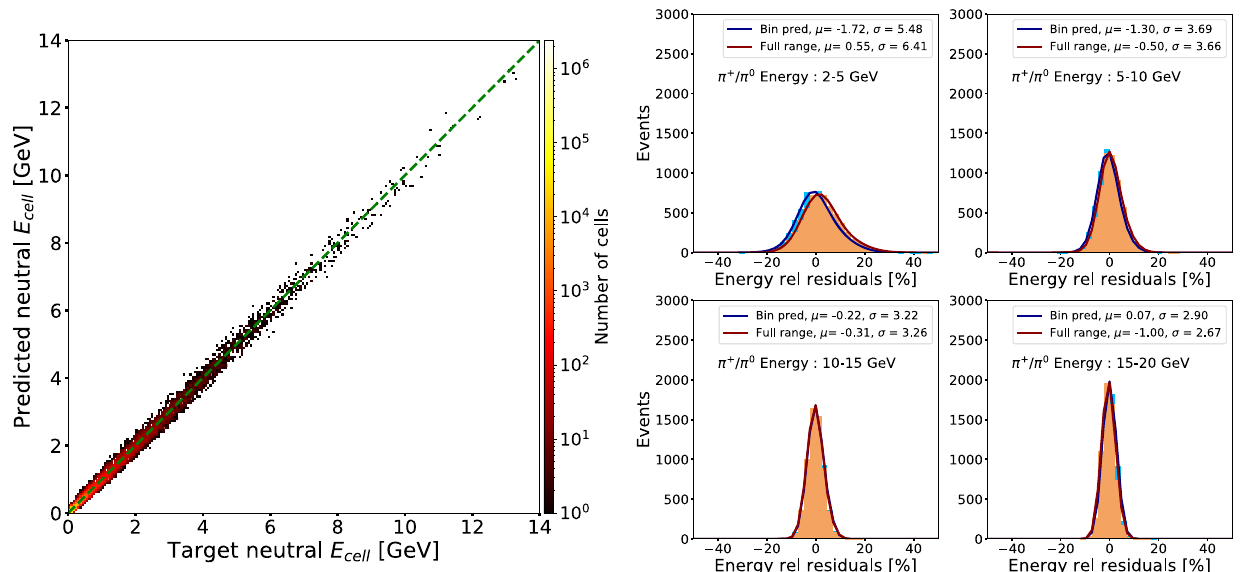
Fig. 4 (left) Distribution of the predicted cell neutral energy as a func- tion of the truth deposited neutral energy for the entire energy range of interest. (right) Topological cluster level relative energy residuals ( E − E )/( E ) in specific energy ranges. The blue predicted Neutral Neutral